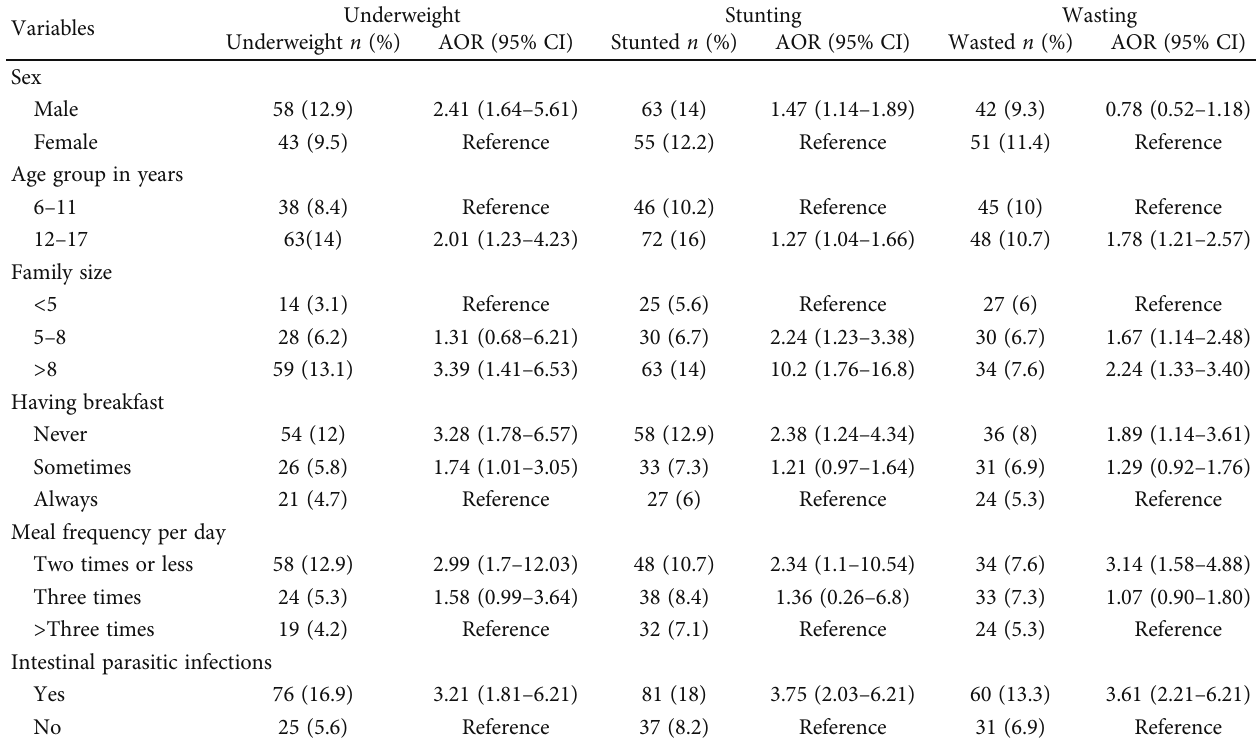
Table 6: Factors associated with the prevalence of underweight, stunting, and wasting among primary school children in Dessie town, North-central Ethiopia,